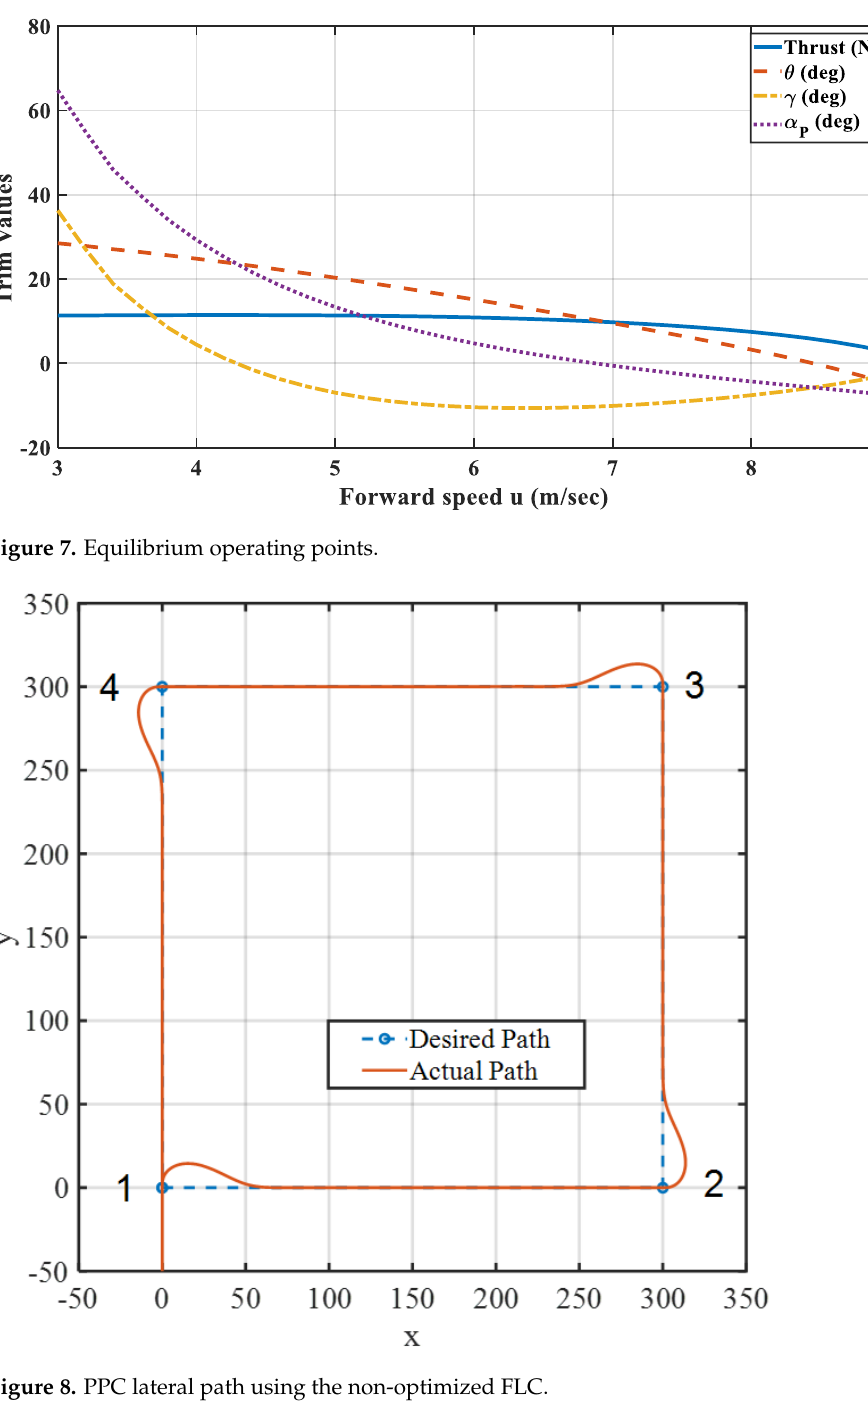
Figure 9. Yaw angle error using the non-optimized FLC.